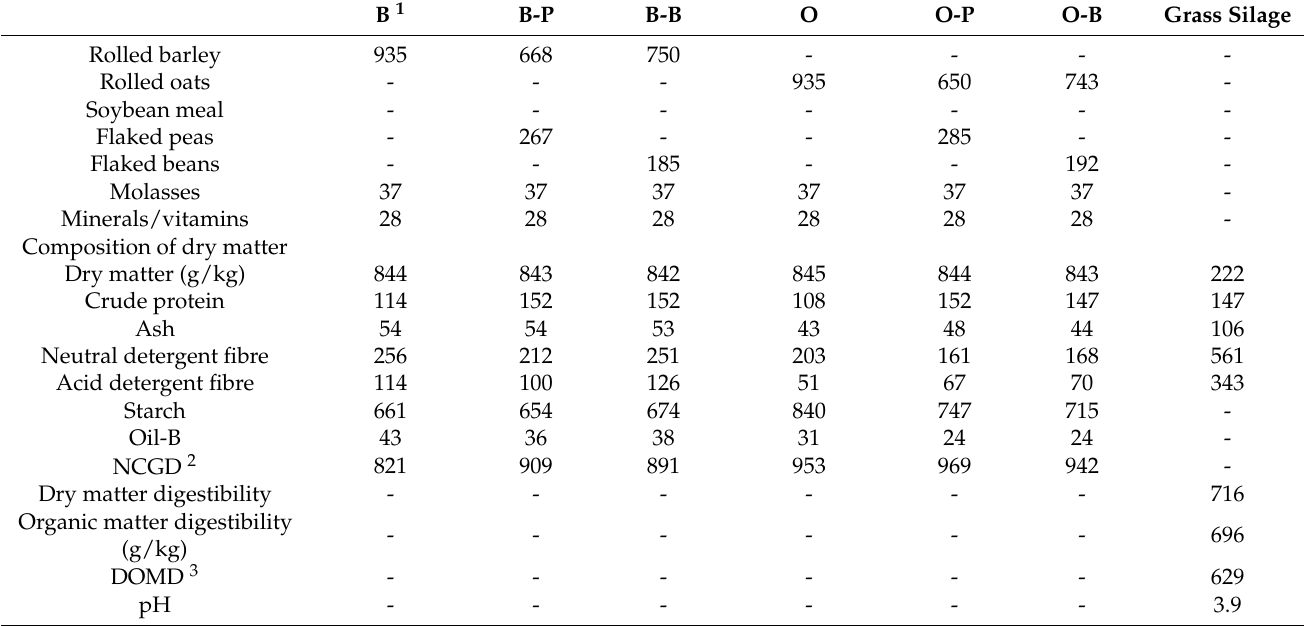
Table 4. Dry matter, chemical composition and in vitro digestibility (g/kg DM unless otherwise stated) of the perennial ryegrass-dominant grass silage and experimental concentrate rations used in Experiment 3. B 1 B-P B-B O O-P